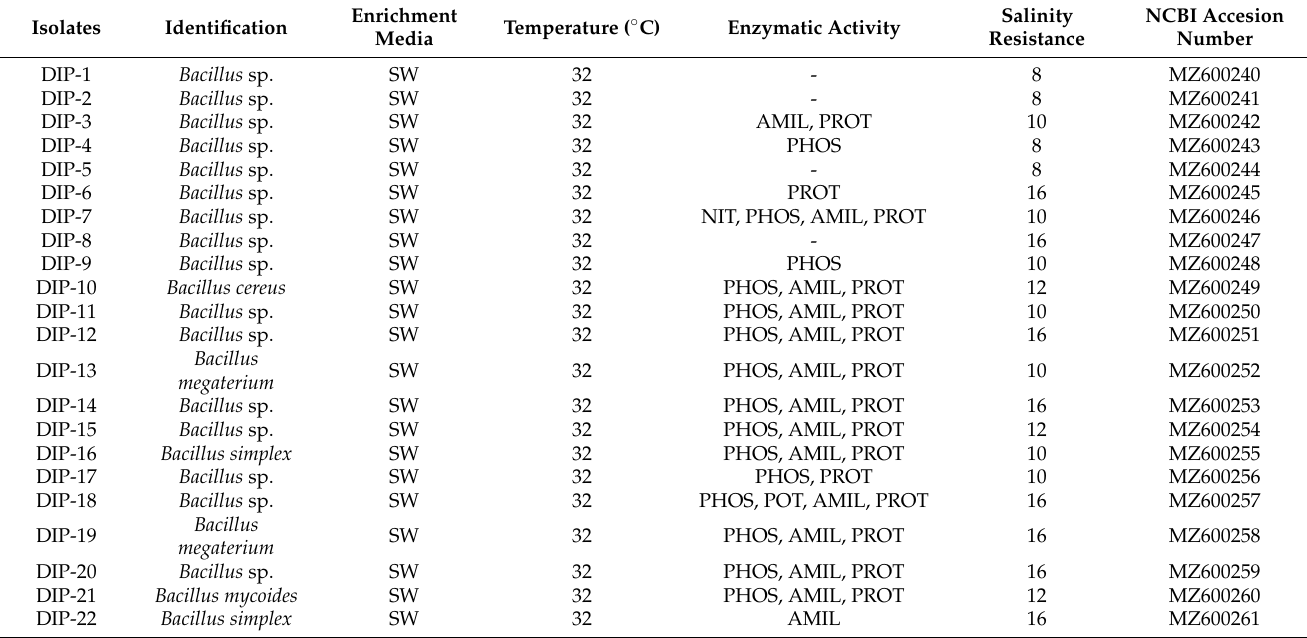
Table 3. Isolated bacterial strains in the sediment. Culture media and temperature of isolation. Isolates